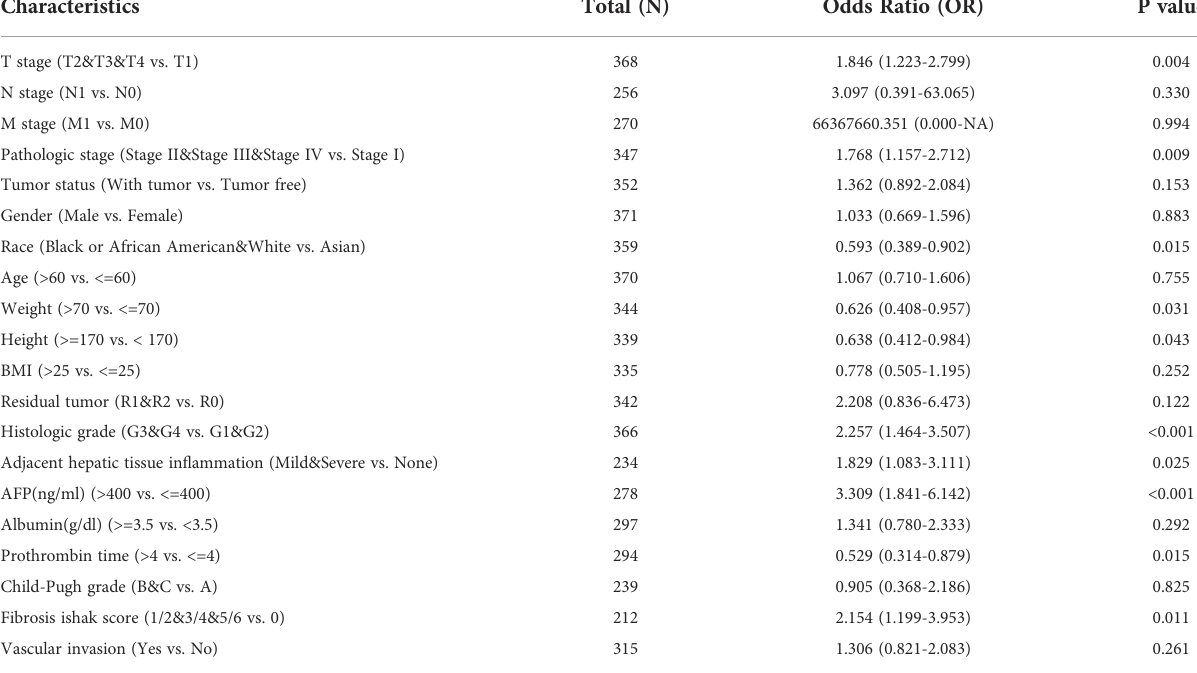
TABLE 2 Single-gene binary logistic regression.